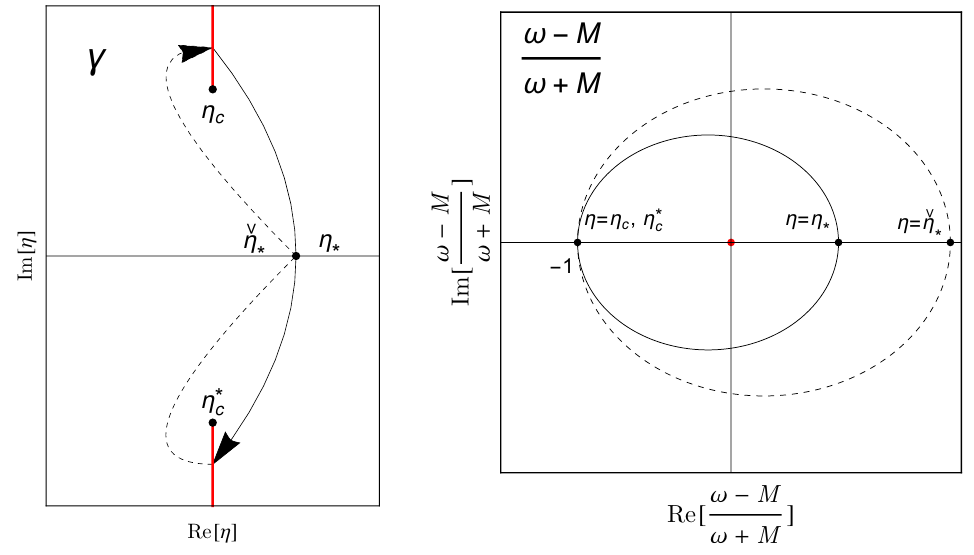
Figure 10 . The left panel shows the loop contour γ . The function ω ( η ) is double-valued, with branch cuts (red lines) emanating from the turning points η c and η ∗ . η ∗ is the crossing point on c the “positive” sheet (on which ω ( η ) > 0 for real η ), and ˇ η ∗ is the point corresponding to η ∗ on the “negative” sheet. γ starts from η c , passes η ∗ on the “positive” sheet, reaches η ∗ , crosses the branch c cut, passes ˇ η ∗ on the “negative” sheet, and returns back to η c . The part of γ on the “positive” sheet is shown in solid curve, and the part of γ on the “negative” sheet is shown in dashed curve. The right panel shows the value of ( ω − M ) / ( ω + M ) as η varies over the loop γ . At η = η c or η = η ∗ , ω = 0 , c so the value ( ω − M ) / ( ω + M ) = − 1 ; at η = η ∗ , the value is ( ω ( η ∗ ) − M ( η ∗ )) / ( ω ( η ∗ ) + M ( η ∗ )) ; at η = ˇ η ∗ , ω (ˇ η ∗ ) = − ω ( η ∗ ) , so the value is ( − ω ( η ∗ ) − M ( η ∗ )) / ( − ω ( η ∗ ) + M ( η ∗ )) . As η varies along the path η c → η ∗ → η ∗ → ˇ η ∗ → η c , the value of ( ω − M ) / ( ω + M ) forms two loops around the origin c (red point). The orientation of the two loops depends on the function ( ω − M ) / ( ω + M )